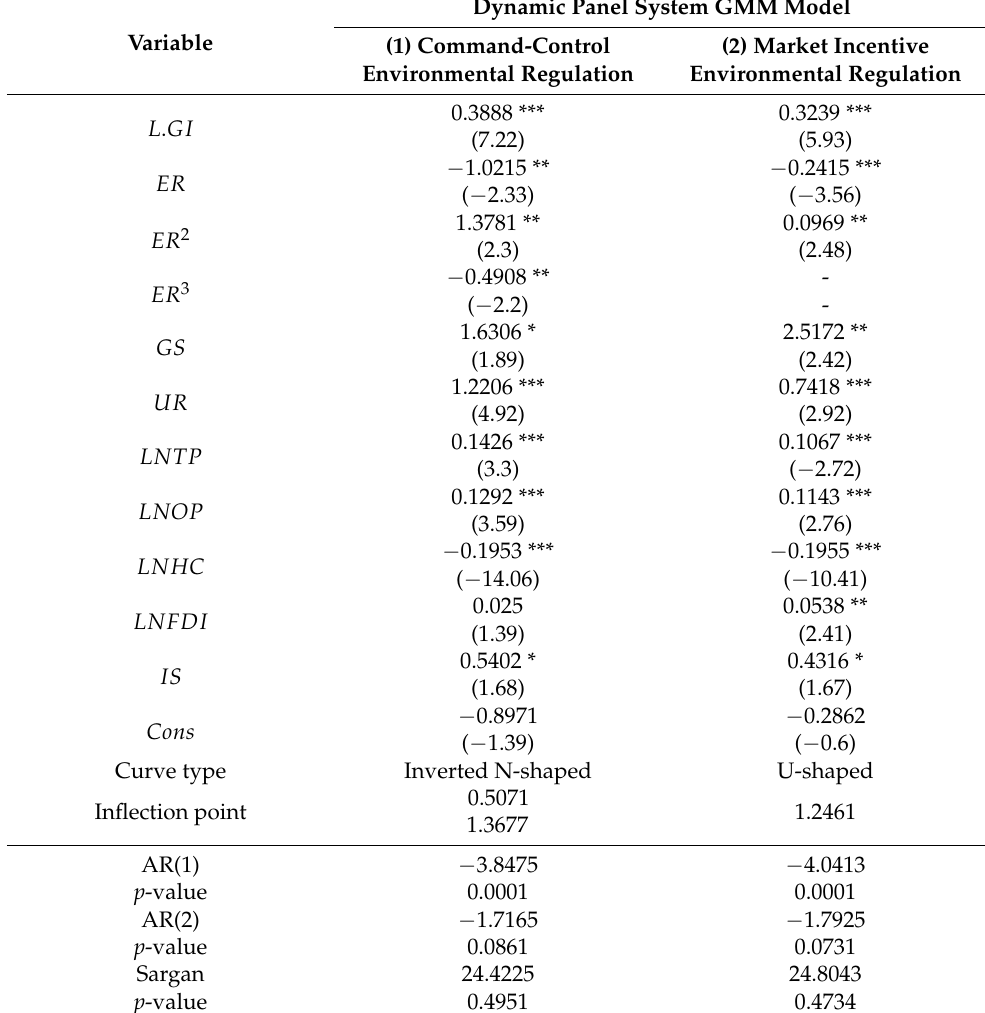
Table 4. Regression results of impact of environmental regulation on green innovation